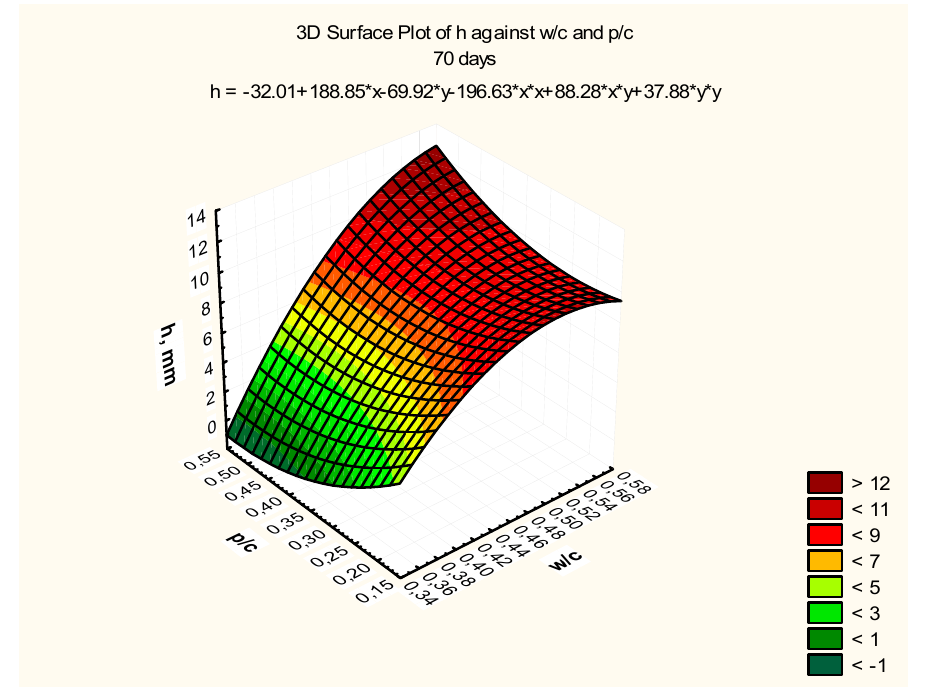
Figure 8. Depth of carbonation as a function of w/c and p/c, after exposure time t = 70 days, R 2 = 0.92.